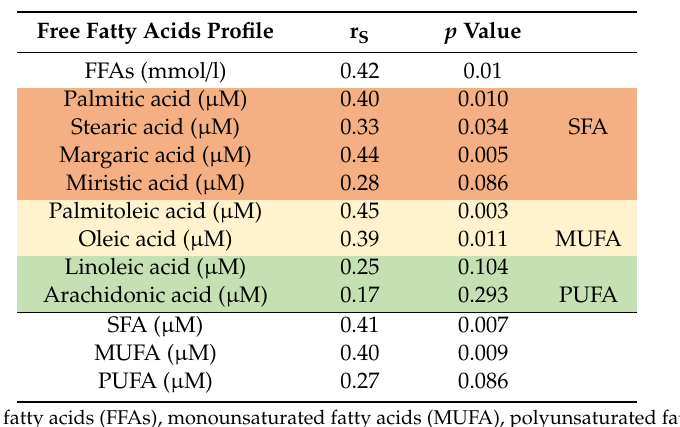
Table 3. Correlation between selenoprotein P levels and the composition of free fatty acids: saturated fatty acids (red), monounsaturated fatty acids (yellow) and polyunsaturated fatty acids (green).